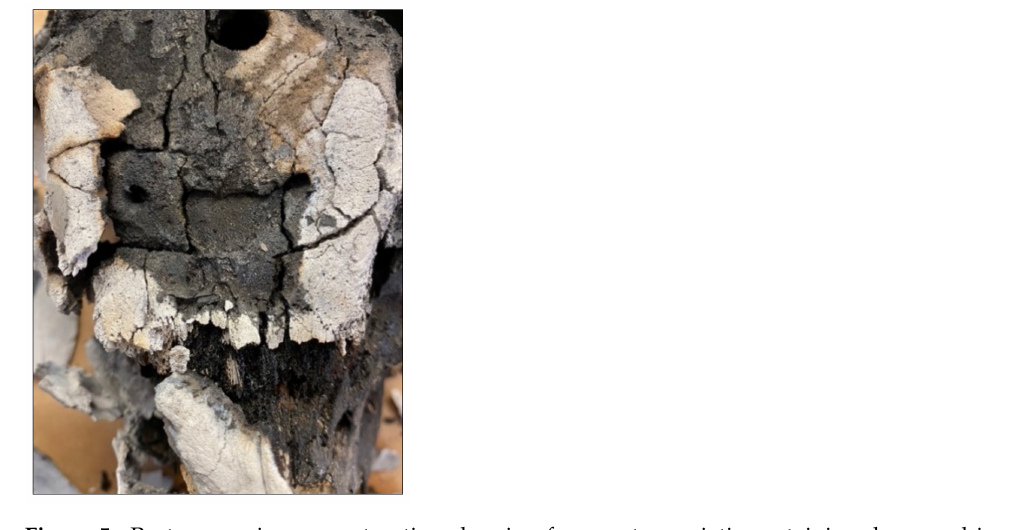
Figure 5. Post-processing reconstruction showing fragment association retaining depressed im- pact